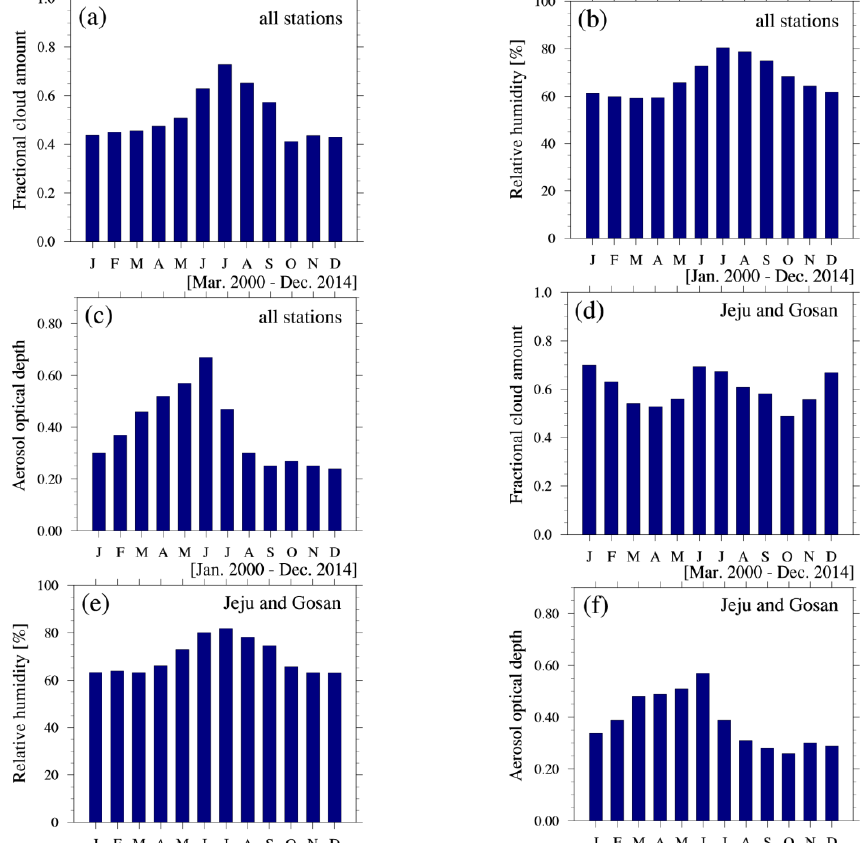
Figure 3. Temporal variations in monthly mean ( a ) CA; ( b ) RH; and ( c ) AOD, averaged over all 21 sites; ( d – f ) Same as (a–c) but for the Jeju and Gosan sites.